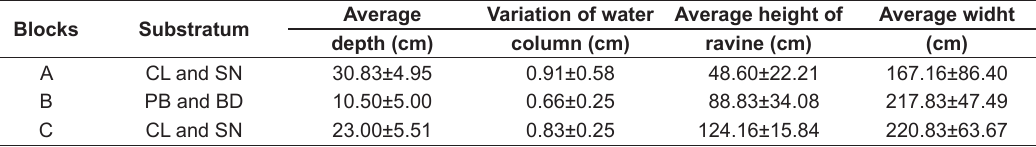
Table 1. Characteristics of the three blocks sampled at the Saltinho stream during the rainy season in May, 2013 at the Biological Reserve of Saltinho, Tamandare city – Pernambuco, Brazil. BD = Boulders; CL = Clay; PB = Pebbles; SN = Sand.